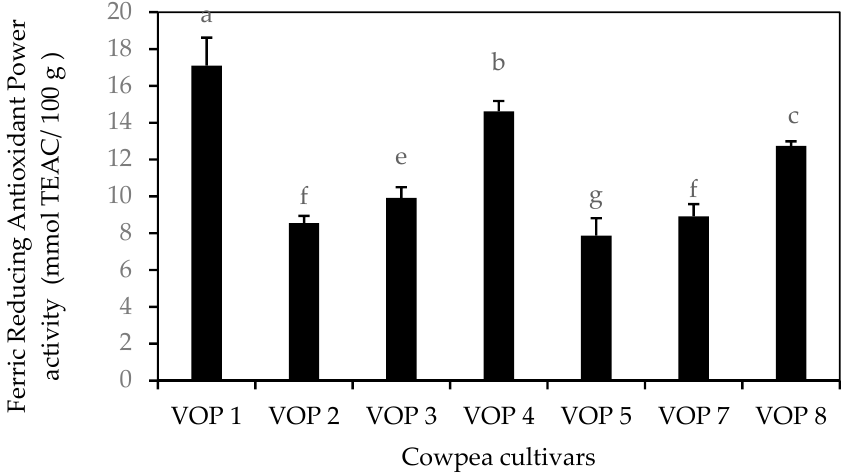
Figure 5. Antioxidant capacity of the leaves of di ff erent cowpea (leaves) cultivars. Bar with same alphabets are not significantly di ff erent between cultivars at p < 0.05. Data obtained were subjected to analysis of variance (ANOVA) using the statistical programme. Each bar represents the mean and standard deviation ( n = 5).